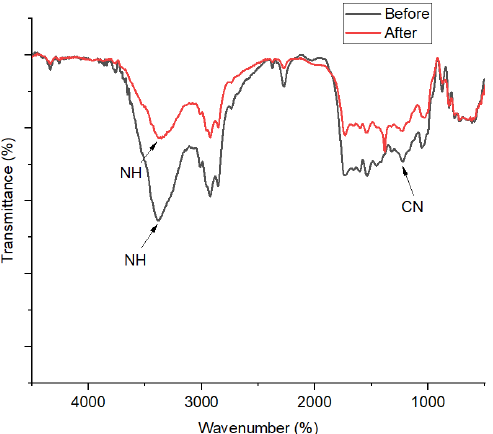
Figure 10. FT-IR spectra of 1,10-phenanthroline-immobilized PU membranes before and after use for Pb 2+ analysis.